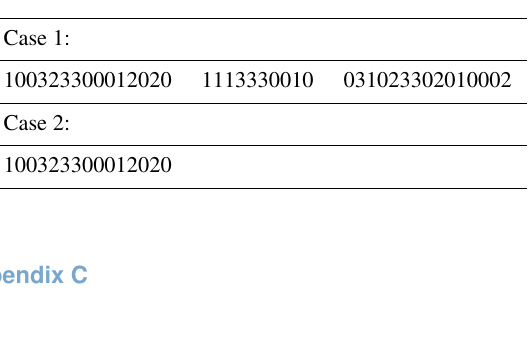
Table C1. The complete database of 1 DOF six-bar